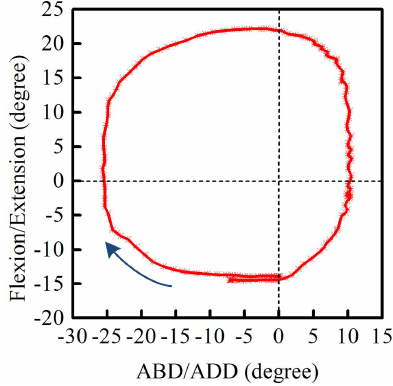
Figure 9. The circumduction of the metacarpophalangeal joint of the left index